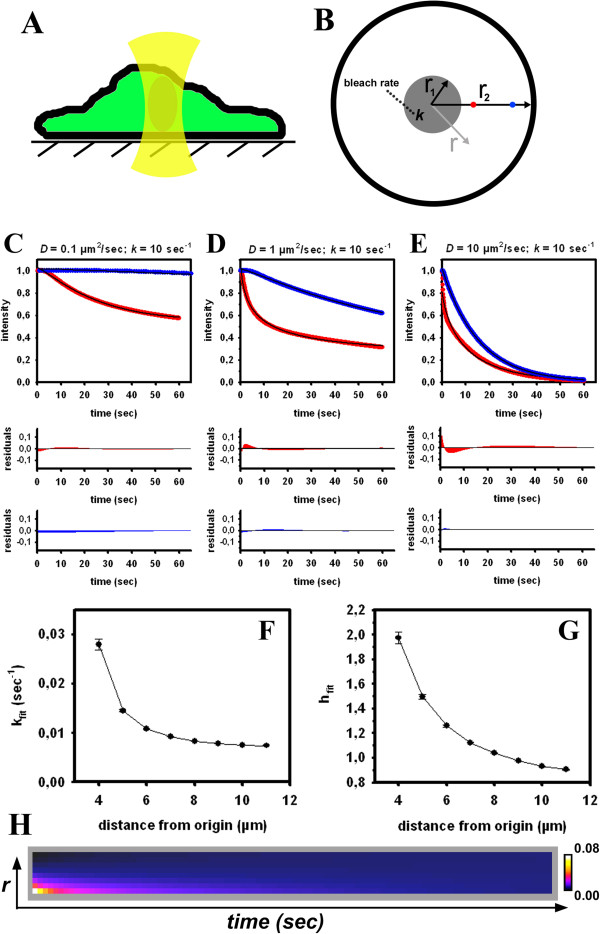
Simulation of homogenous diffusion and fitting with the StrExp function.A, Sketch of the FLIP experiment with the cell attached to a surface and filled with eGFP (green) and the cylindrical laser beam focused in the cell center (yellow). B, Geometry of the analytical model for the reaction diffusion system in Eq. 6 to model the FLIP experiment. The cell is assumed to be a flat cylinder with a radius, r2 = 12 μm. The central bleached region with radius r1 = 3 μm is also cylindrical covering the whole cell height (grey shaded area). C-E, The model was solved analytically and simulated for two positions outside the bleached area at a distance of 5 μm (red dot in B and red symbols in C-E) and 10 μm (blue dot in B and blue symbols in C-E) from the origin, respectively. Simulations were performed with a rate constant for the intended bleaching process of k = 10 sec-1 and diffusion constants of D = 0.1 μm2/sec (C), D = 1 μm2/sec (D) and D = 10 μm2/sec (E). A non-linear regression with the StrExp function (black lines) was performed in SigmaPlot (upper panels) including the residuals of the fit (lower panels). F, G, time courses were simulated for D = 0.1 μm2/sec as a function of distance from the origin and fitted to the StrExp function. Fitted parameters including standard deviation of the fit are plotted for the rate constant (‘kfit’; F) and stretching parameter (‘hfit’; G). H, rate coefficients calculated according to Eq. S4 for the parameters in panels F, G as function of distance from bleach ROI (starting at 4 μm from origin and indicated as ‘r’ on the ordinate in H) over time. The scale bar shows rate coefficients color-coded using a FIRE-LUT